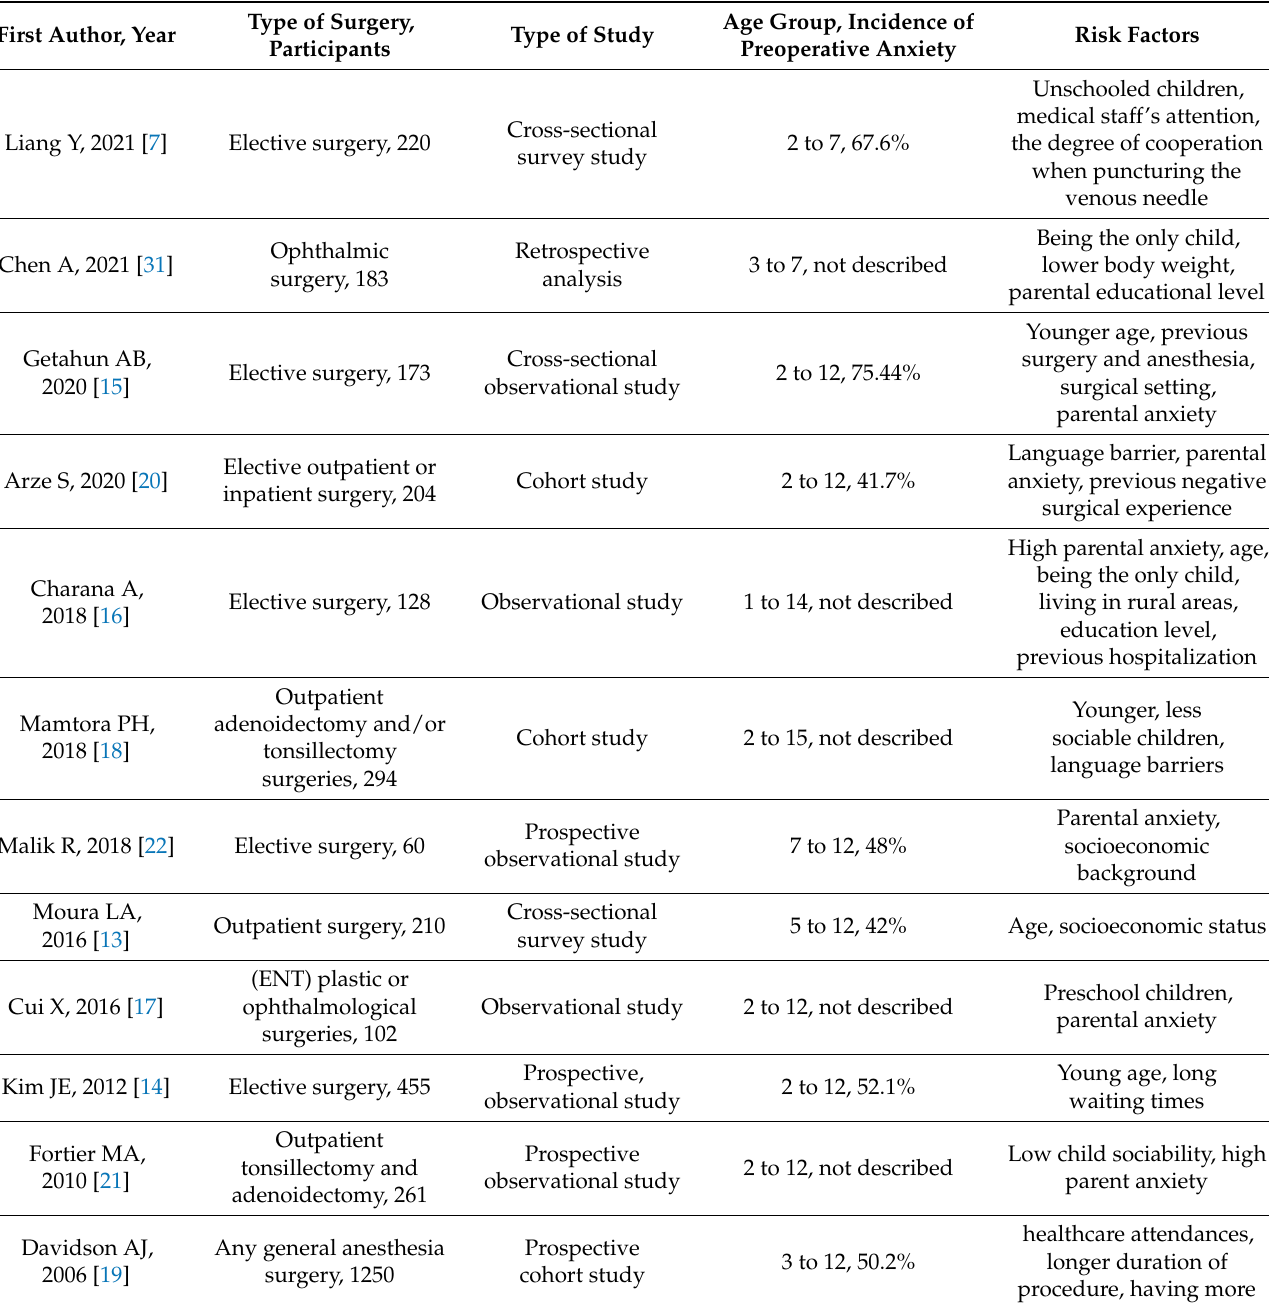
Table 1. Summary of risk factors of preoperative anxiety in